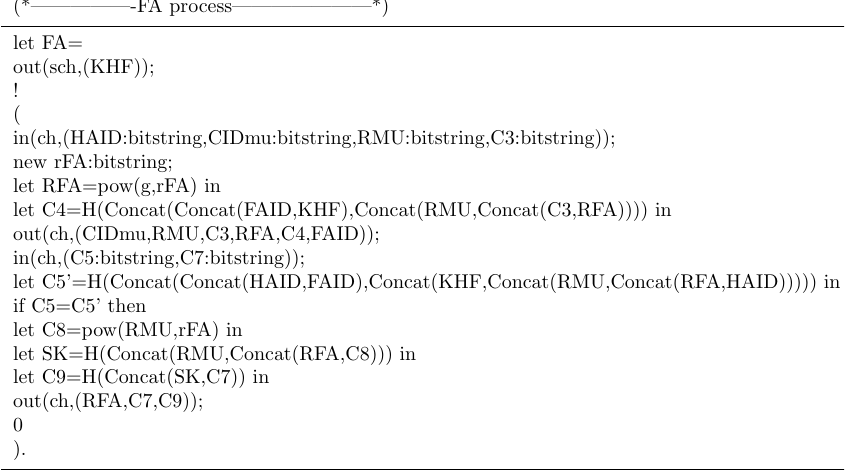
Figure 5. Verification code for